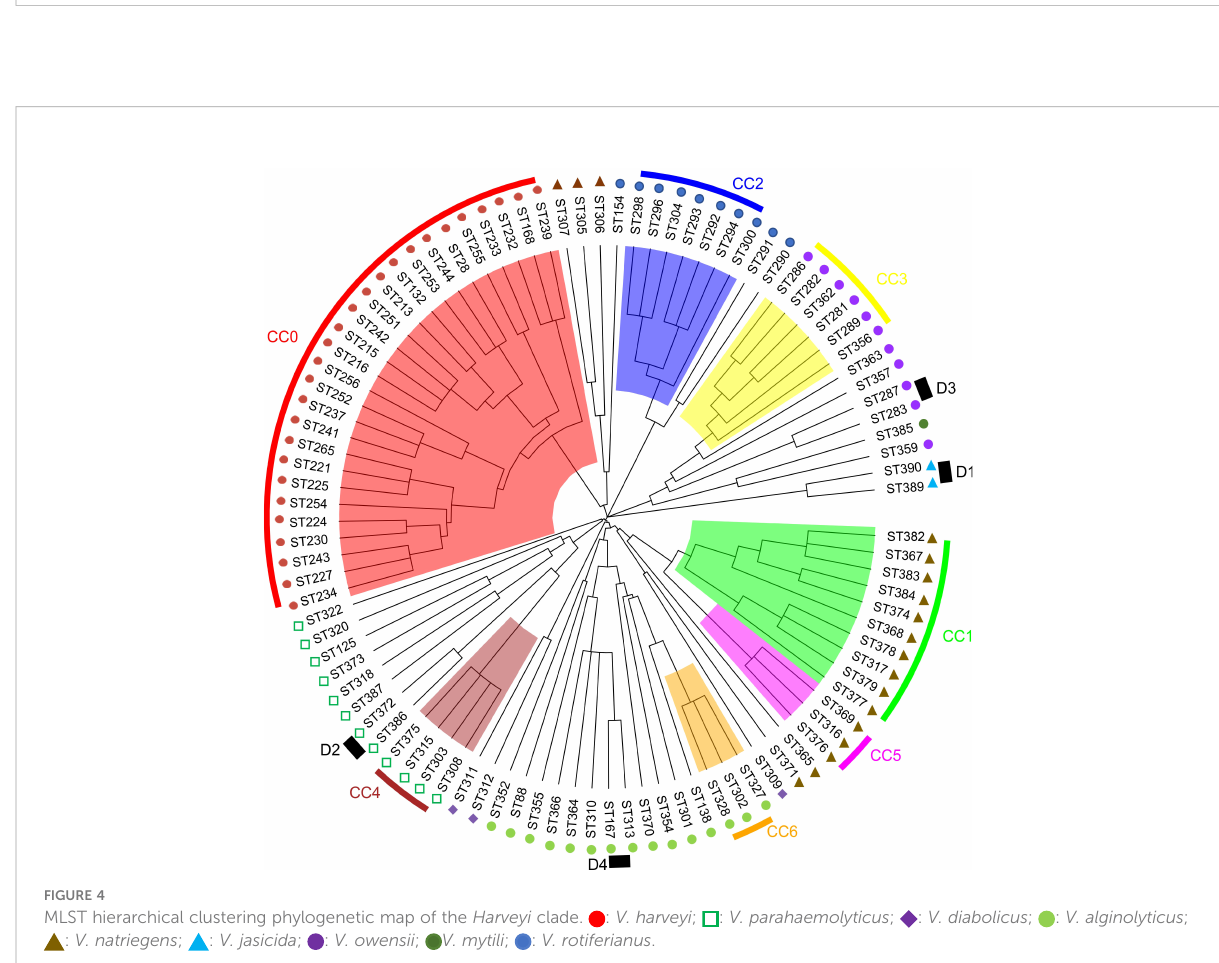
FIGURE 4 MLST hierarchical clustering phylogenetic map of the Harveyi clade. : V. harveyi ; : V. parahaemolyticus ; : V. diabolicus ; : V. alginolyticus ; : V. natriegens ; : V. jasicida ; : V. owensii ; V. mytili ; : V. rotiferianus .